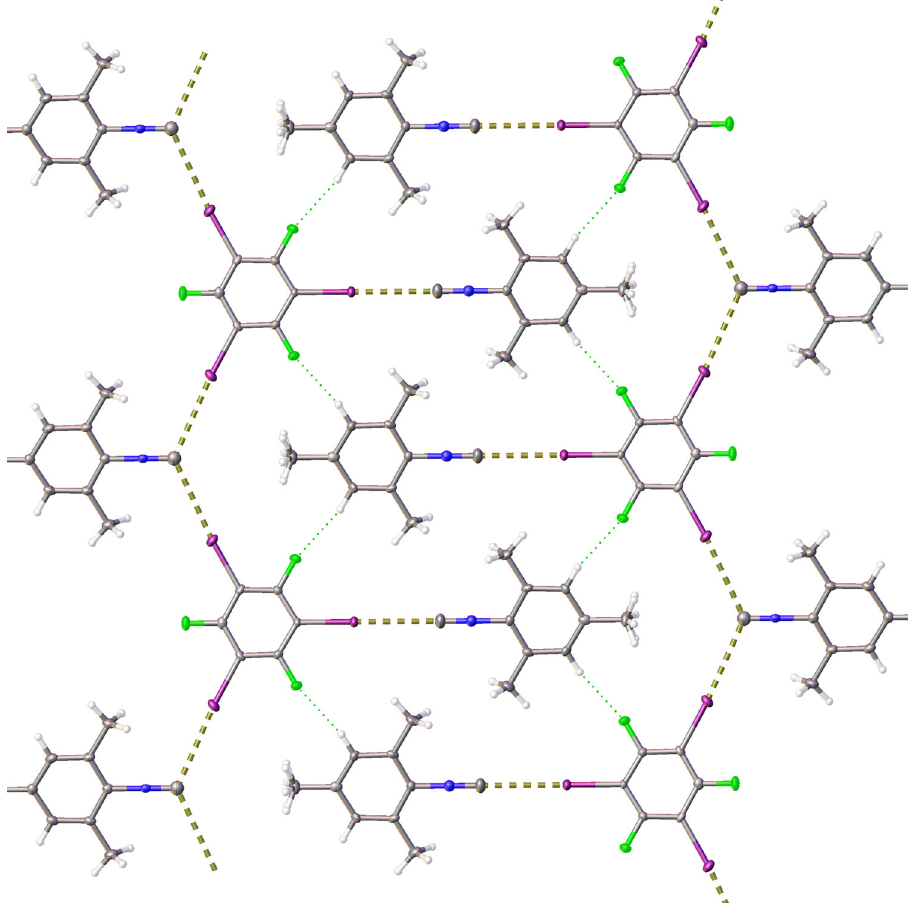
Fig. 2 2D layer in the crystal structure of (CNMes) 2 (cid:129) 1,3,5-FIB. The yellow dotted lines indicate the I···C XBs, the green dotted lines depict the C – H···F